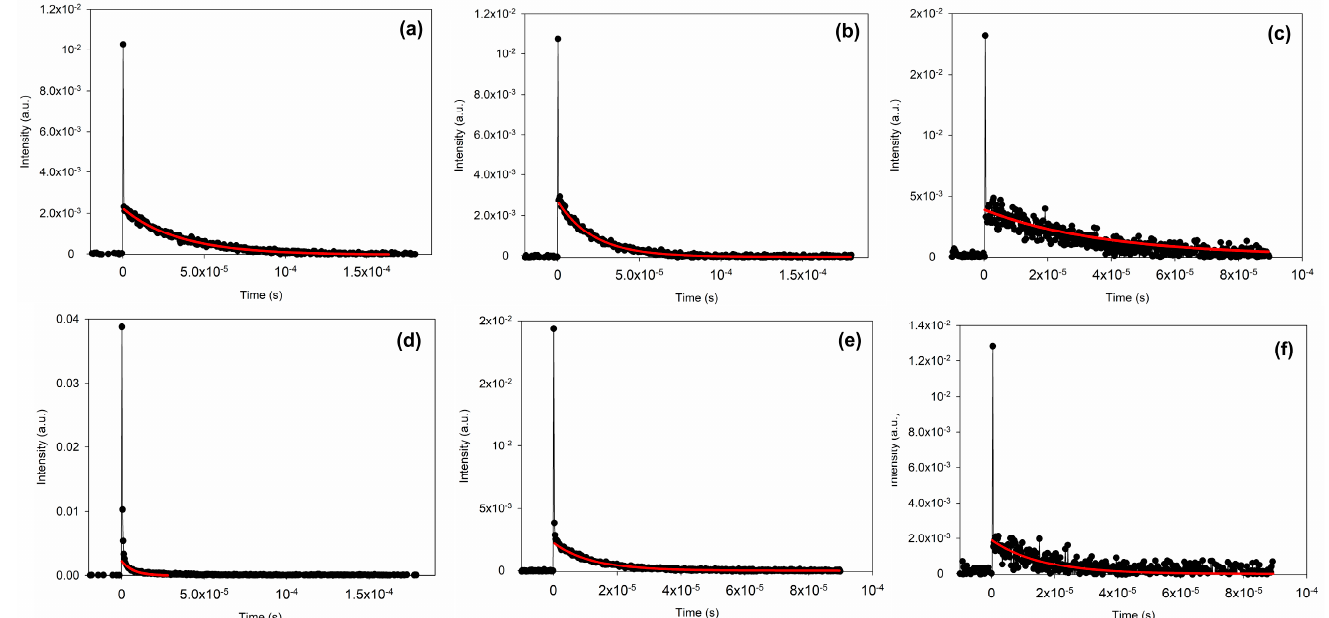
Figure 5. Singlet oxygen phosphorescence emission decays collected at 1275 nm after photosensitiza-